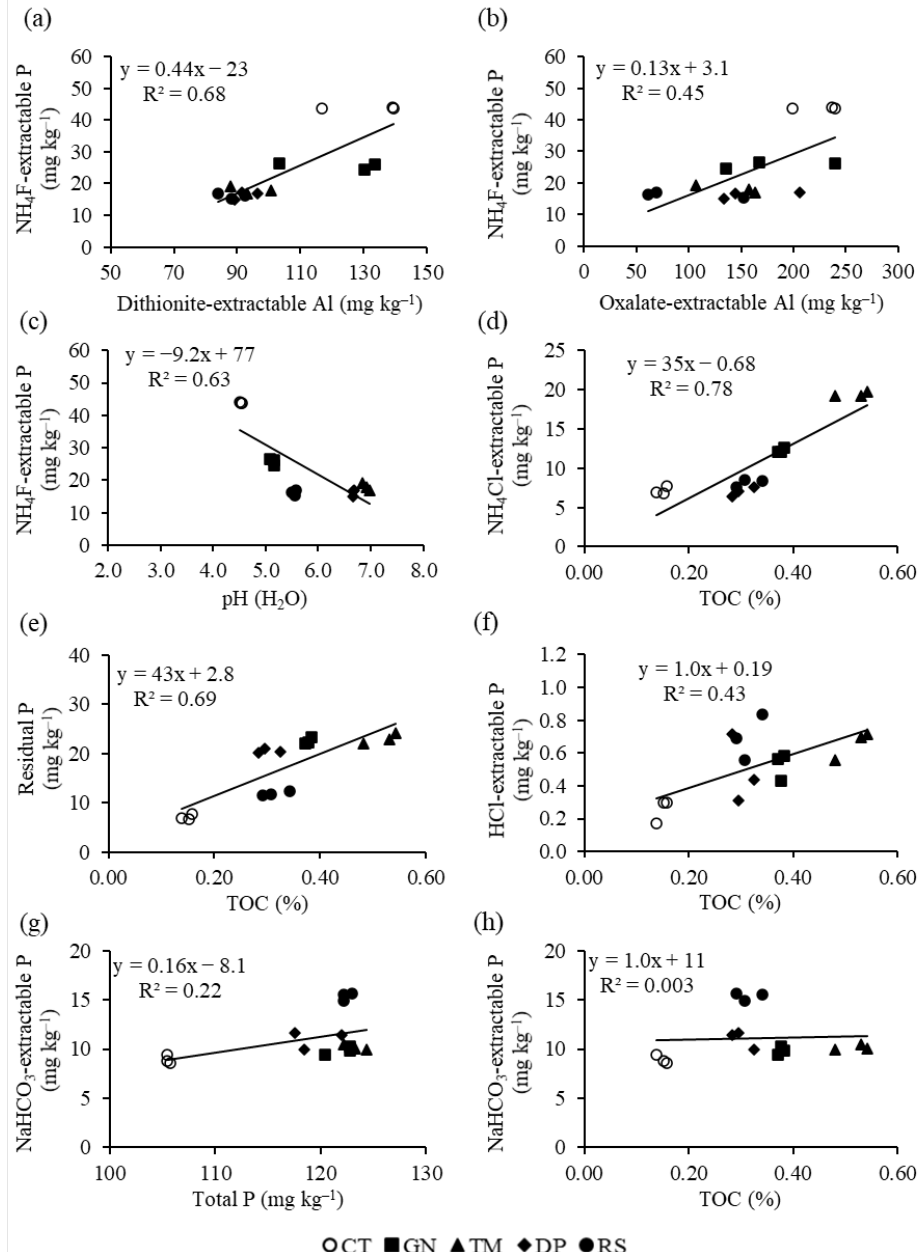
Figure 4. Bivariate relationships between dithionite-extractable Al and NH 4 F-extractable P ( a ), oxalate-extractable Al and NH 4 F-extractable P ( b ), pH (H 2 O) and NH 4 F-extractable P ( c ), TOC and NH 4 Cl-extractable P ( d ), TOC and residual P ( e ), TOC and HCl-extractable P ( f ), total P and NaHCO 3 -extractable P ( g ), and TOC and NaHCO 3 -extractable P ( h ) for tropical sandy soil under the incorporation of organic residues.